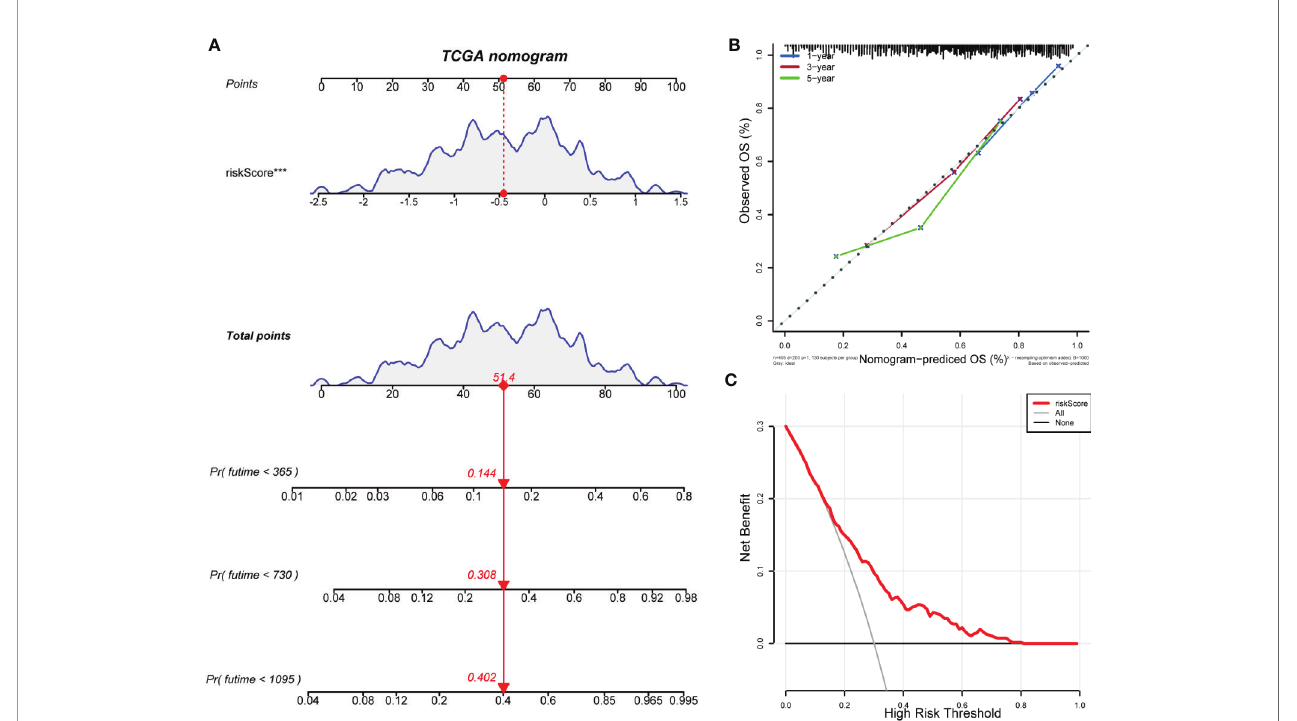
FIGURE 4 | Establishment and evaluation of nomogram model. (A) Nomogram predicting the probability of TCGA patient ’ s mortality based on IRLPs and clinical variables. (B) Calibration curves of the nomogram for 1, 3 and 5 years. (C) Decision curve analysis of the nomograms based on the IRLPs